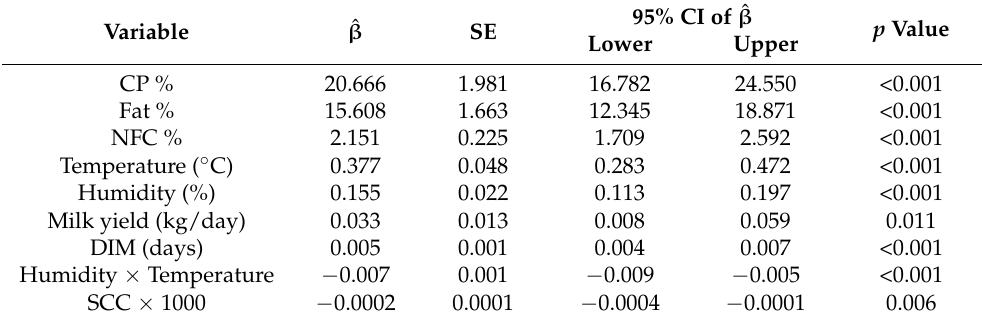
Table 2. Predictors of MUN concentration (from a multivariable linear mixed-effects regression model) in the study to investigate the effect of ambient temperature and relative humidity on milk urea nitrogen (MUN) concentration. Data were collected from 161 Holstein cows at the Experimental Farm, University of Pretoria, during the period from February 2012 to November 2017.